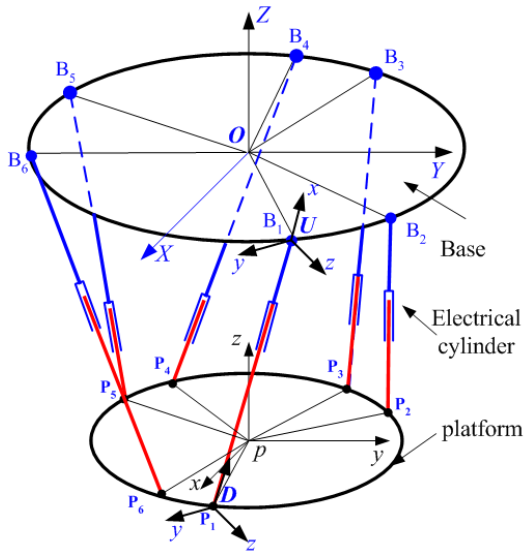
Figure 5. Schematic diagram of Stewart platform.